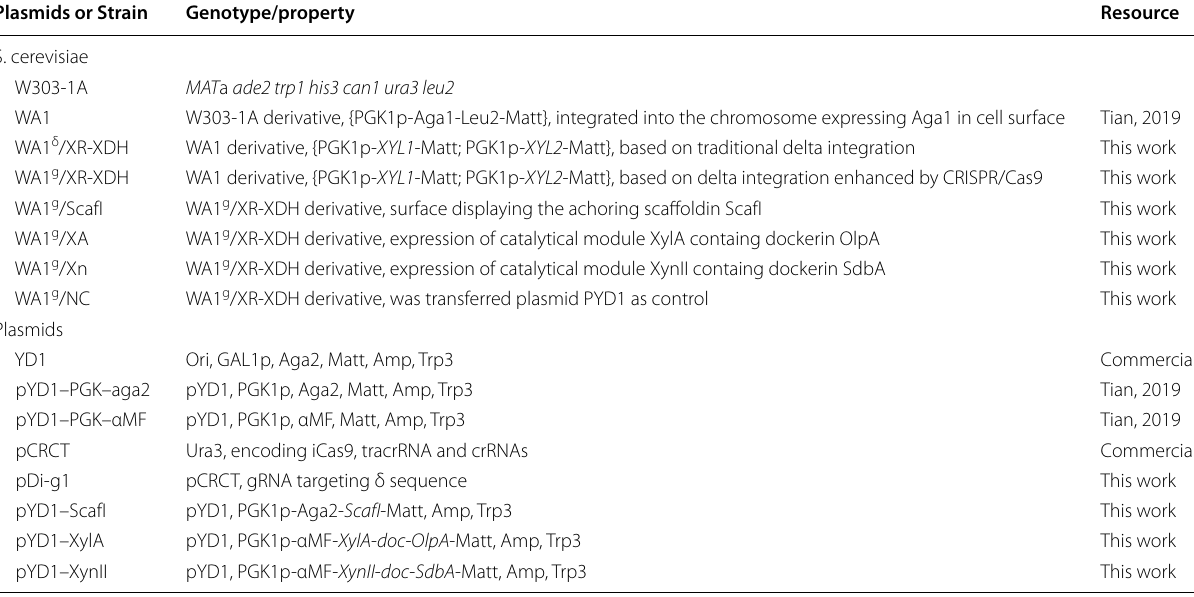
All values are averages standard deviation of three independent experiments ± a Data shown as percentage of dry Matter (DM) b Acid-soluble lignin included c Non-structural material and other compounds from biomass Table 2 Summary of the recombinant S. cerevisiae strains used in this study Plasmids or Strain Genotype/property